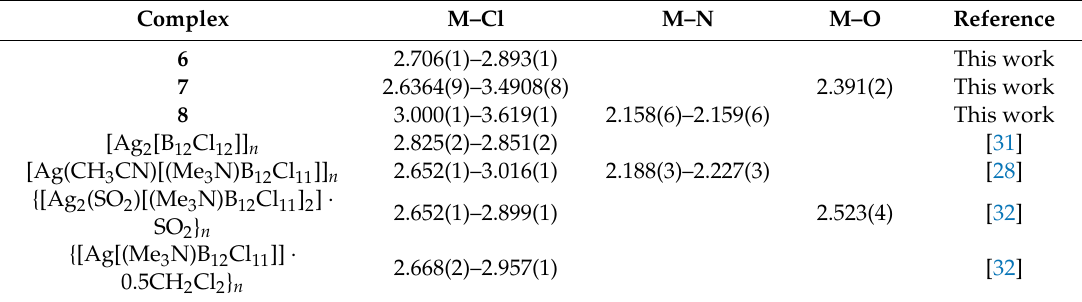
Table 3. Selected parameters (Å) of silver(I) coordination polyhedra in complexes with some chlorinated boron cages.